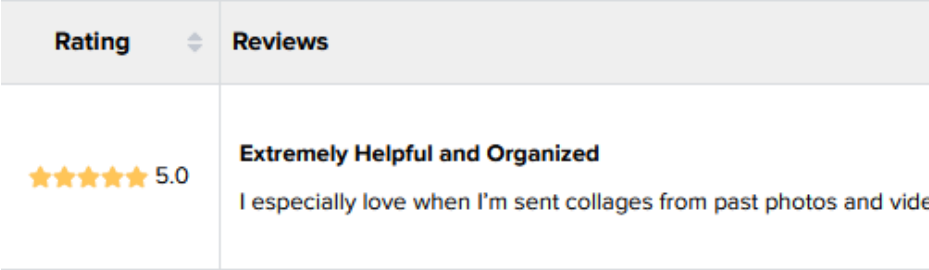
Figure 3. An example of raw